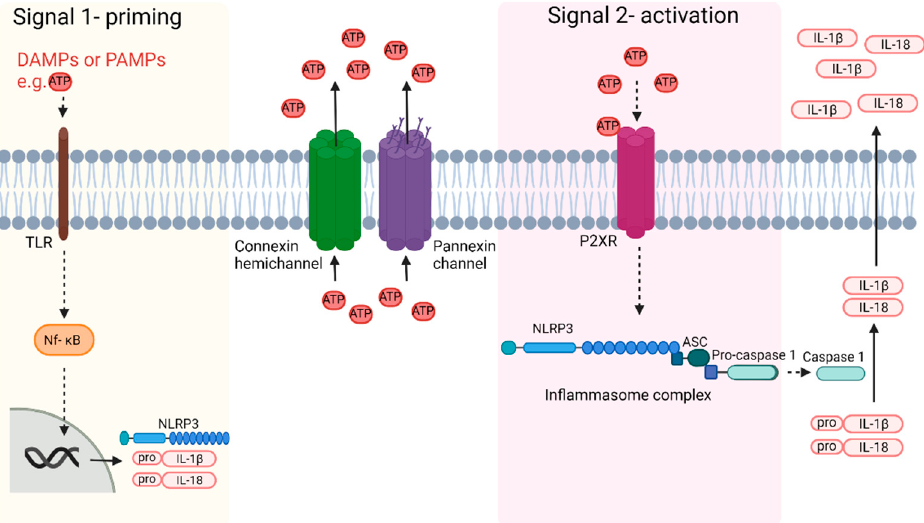
Figure 2. Schematic diagram of activation of the inflammasome. PAMPs and/or DAMPs act as the priming signal 1 and activate TLR, which triggers Nf-kB to move to the nucleus, ultimately resulting in the transcription of NLRP3 and pro-IL-1 β and pro-IL-18. Opening of Cx and pannexin channels then results in ATP release. Extracellular ATP activates P2XR (and its breakdown products ADP and adenosine may act on their respective receptors) which acts as the inflammasome signal 2 activator, resulting in the assembly of the inflammasome complex. Caspase 1 cleavage of pro- IL-1 β and pro-Il-18 then leads to the release of IL-1 β and Il-18, which further potentiate the inflammatory process. Since the pannexin channel self-regulates in an ATP feedback loop, it is the Cx hemichannel which makes a major contribution during prolonged or perpetuated inflammation.